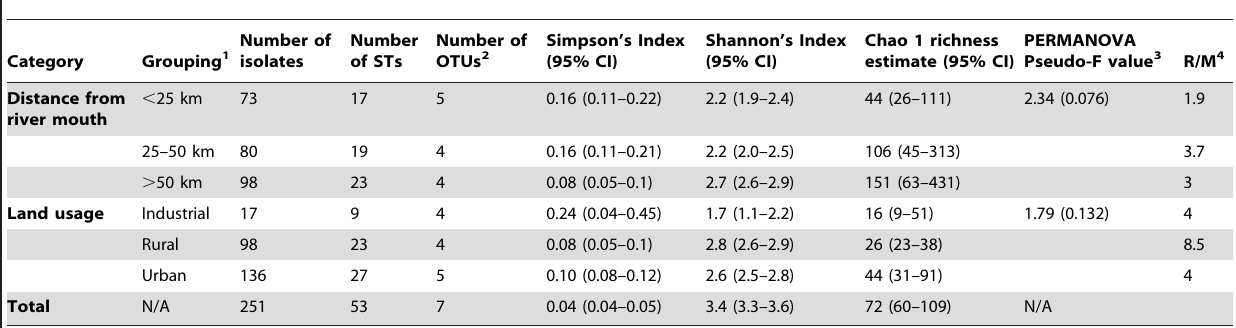
Table 2. Genetic diversity and recombination amongst the 251 Pseudomonas aeruginosa isolates Shannon’s Index (95% CI) collected from the Lower Brisbane River.